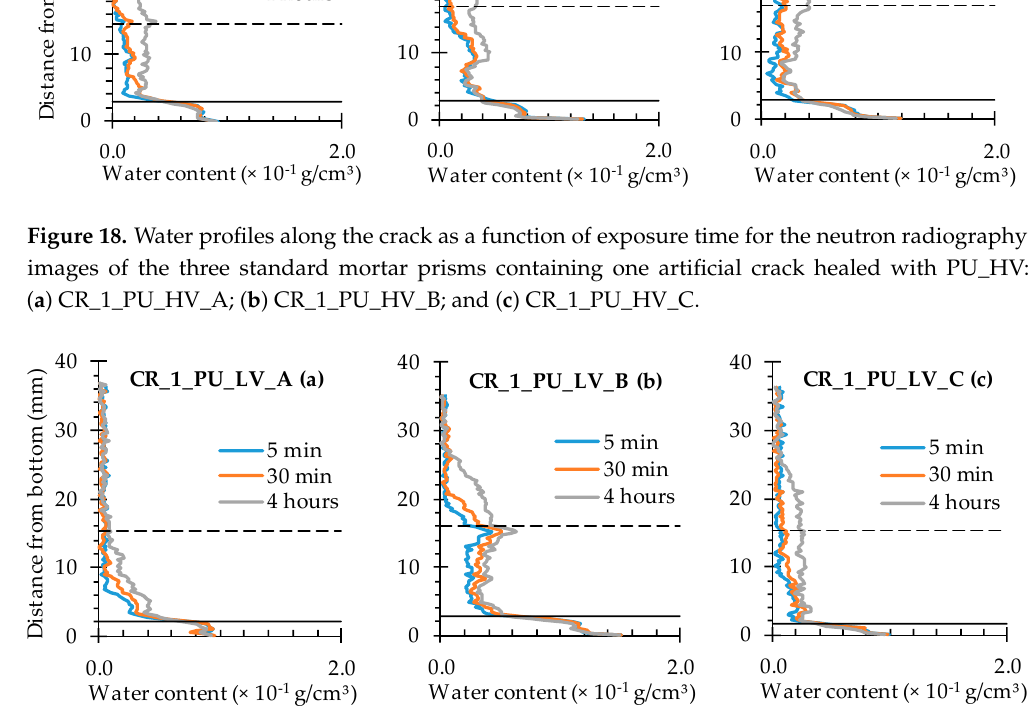
Figure 19. Water profiles along the crack as a function of exposure time for the neutron radiography images of the three standard mortar prisms containing one artificial crack healed with PU_LV: ( a ) CR_1_PU_LV_A; ( b ) CR_1_PU_LV_B; and ( c ) CR_1_PU_LV_C.